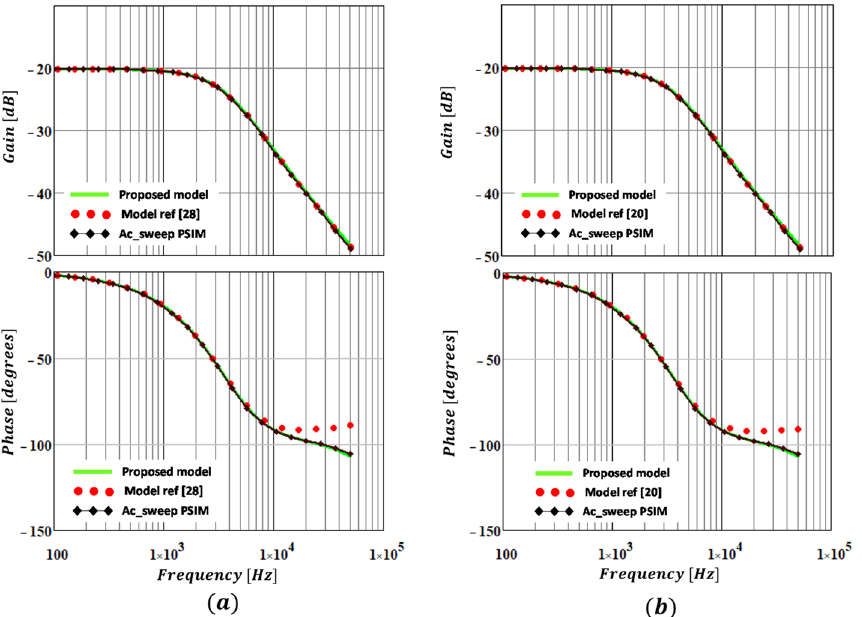
Figure 15. Comparison of the frequency response of the audio-susceptibility transfer function for a power level of 500 W. ( a ) Proposed small-signal model vs. small-signal model presented in [28]. ( b ) Proposed small-signal model vs. small-signal model presented in [20].